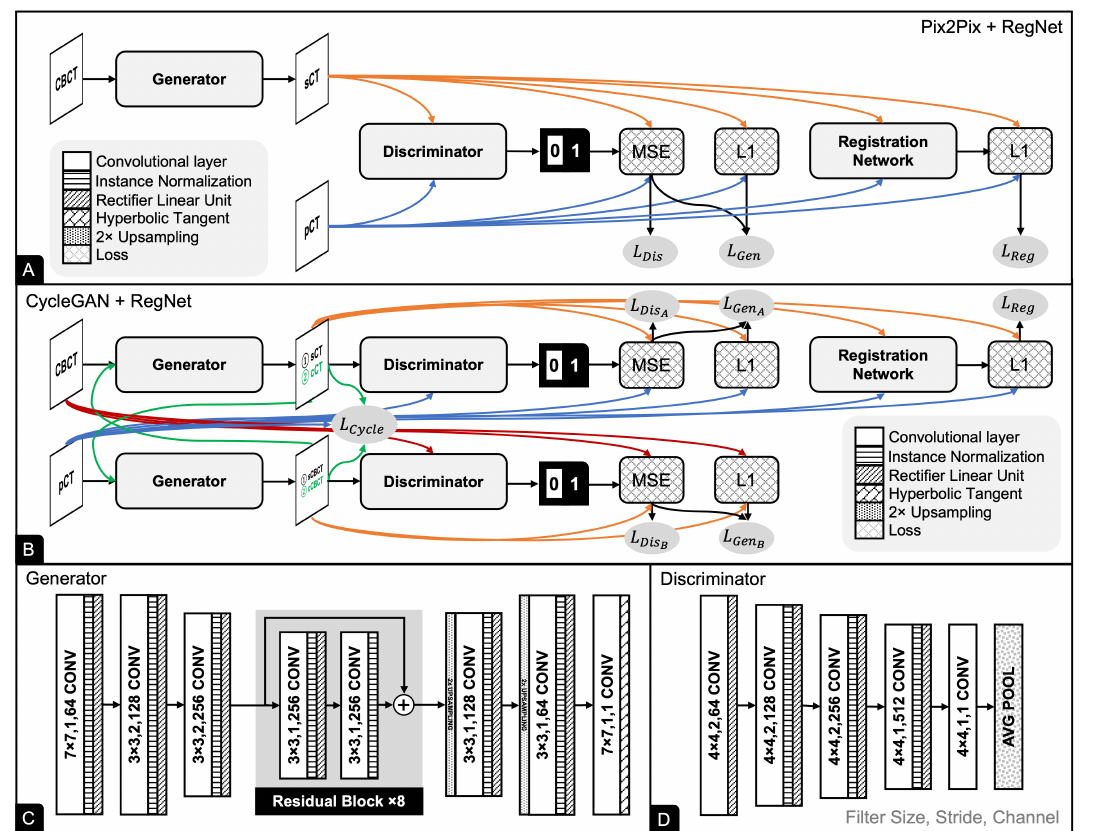
Figure 4. Pix2Pix and CycleGAN share common generator and discriminator architectures. RegNet was coupled with Pix2Pix and CycleGAN during training. ( A ) Pix2Pix has one discriminator and one generator. ( B ) CycleGAN has two discriminators and two generators. ( C ) The generator consists of three convolution blocks, eight residual blocks, and three convolution blocks with upsampling. ( D ) The discriminator comprises a series of convolutions, nonlinear activations, and average-pooling operations. Values in the convolutional layer box indicate the size of the kernel, the number of strides, and the number of channels,